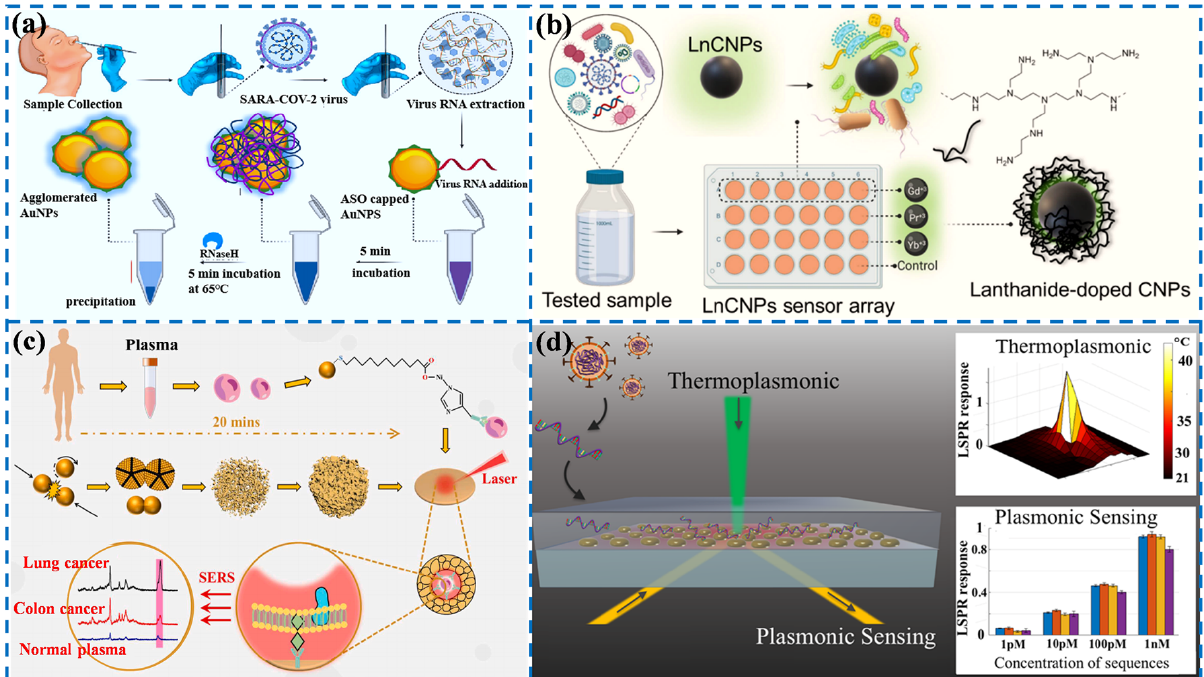
Figure 1. Schematic diagram of optical sensors in biological detection: ( a ) colorimetric sensor for the detection of RNA from SARS-CoV-2. Reprinted with permission from ref. [26]. ( b ) Fluorescent sensor for the identification of SARS-CoV-2 in wastewater. Reprinted with permission from ref. [27]. Copyright 2022, American Chemical Society. ( c ) SERS sensor for the detection of tumor cell exosomes. Reprinted with permission from ref. [28]. Copyright 2022, Elsevier. ( d ) Plasma sensor for the detection of SARS-CoV-2. Reprinted with permission from ref. [29]. Copyright 2020, American Chemical